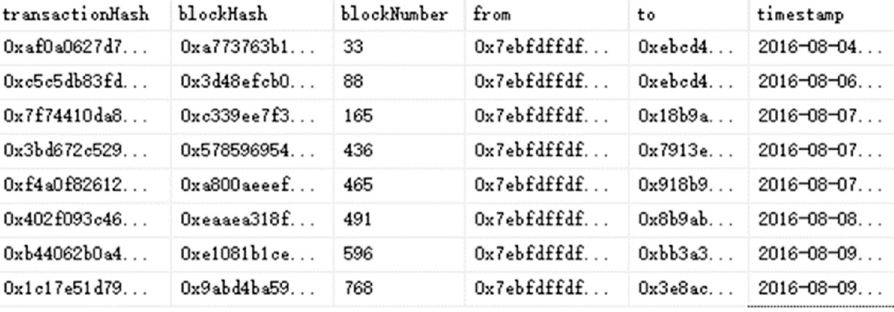
Table 1. An example of the dataset.